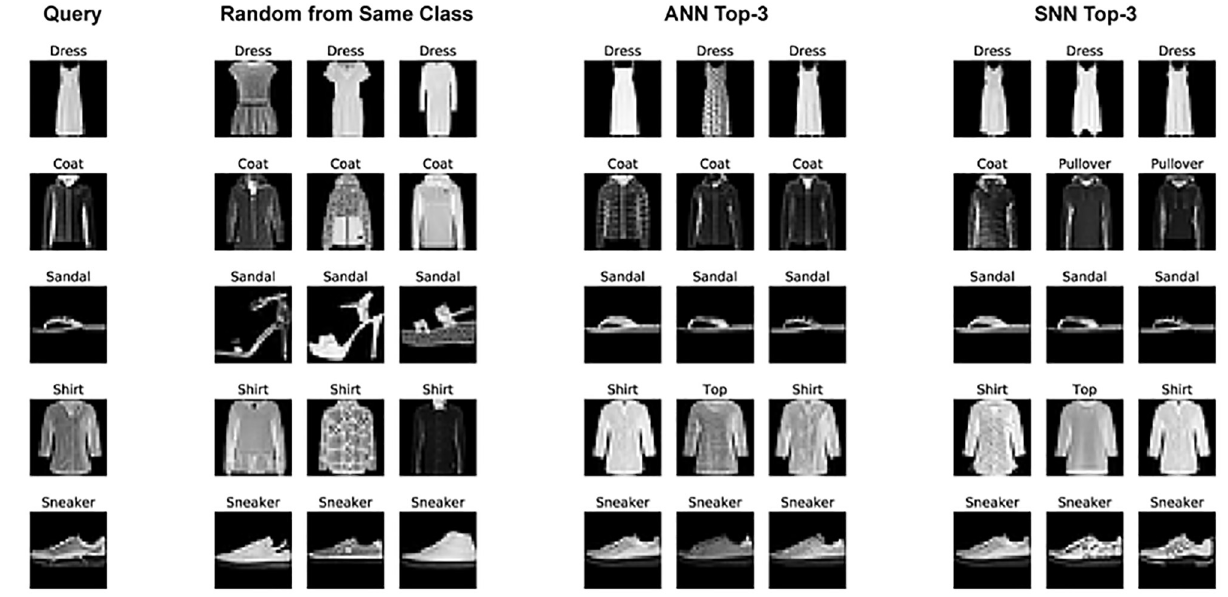
Fig 6. Examples of the image retrieval by the artificial (ANN) and spiking (SNN) neural networks.